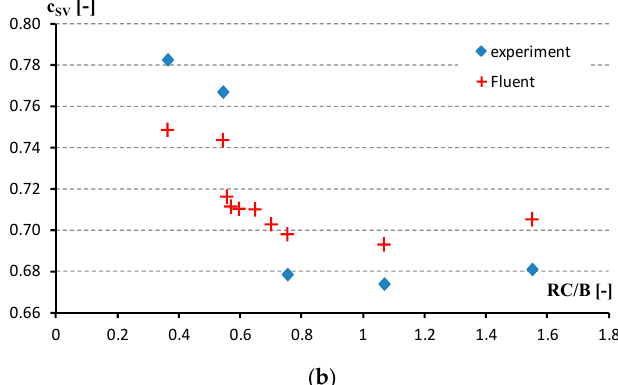
Figure 7. Comparison of data obtained from the experiment with data from CFD calculations; parameter: ( a ) 𝑚(cid:4662) /A and ( b ) c SV depending on RC/B . Data in Figure 7, obtained using the Fluent software, show a slight change of 𝑚(cid:4662) /A and c SV between RC/B = 0.542 and 0.555. For higher values of RC/B, from 0.555 to 0.752, we can observe smooth changes, but at a steep gradient.